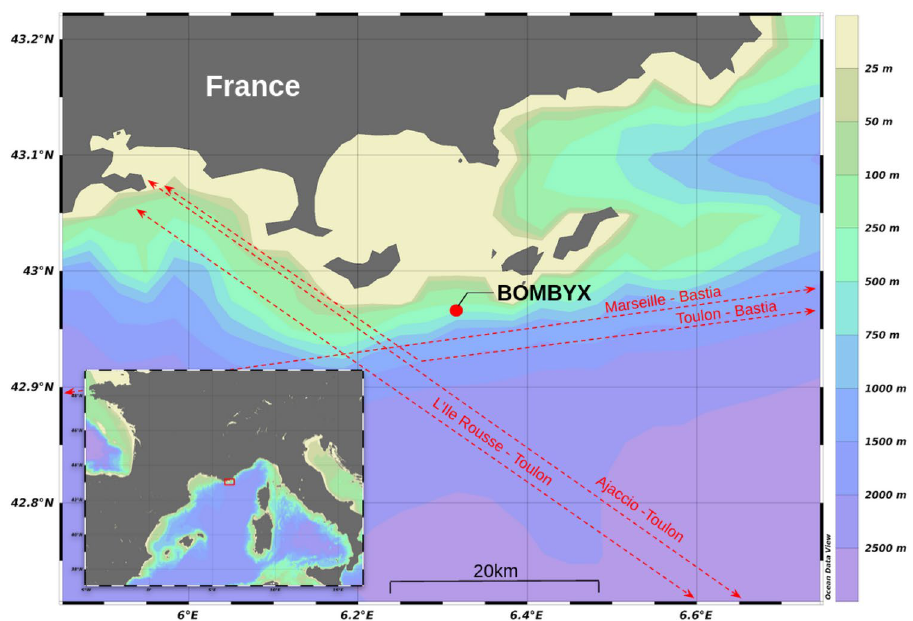
Figure 5. Up: Bathymetric map of the region showing the geographic location of the BOMBYX buoy and the ferry’s trajectories (red lines). The map was made with Ocean Data View (ODV) software 81